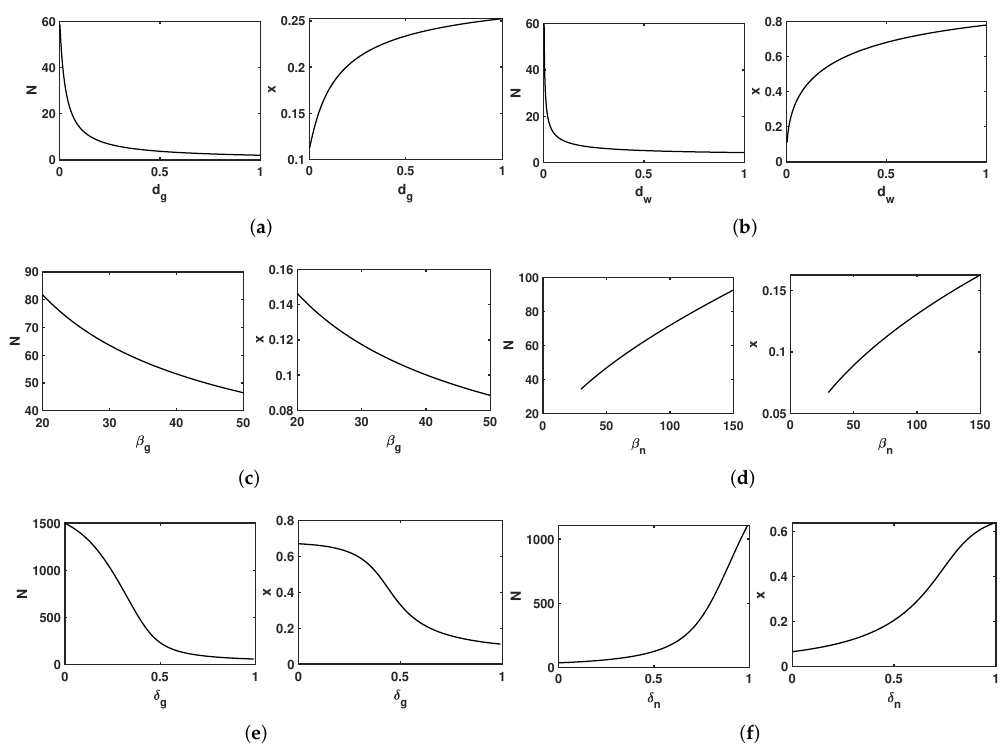
Figure 5. Impact of vital parameters ( d g , and d w ) and metabolic parameters ( β n , β g , δ g and δ n ) in the colony demography and hierarchy social structure, i.e., N an x , respectively. The value used for the vital parameter e is 2.42. ( a ) d w = 0.0025, β g = 33, β n = 74.6, δ g = 0.99, and δ n =